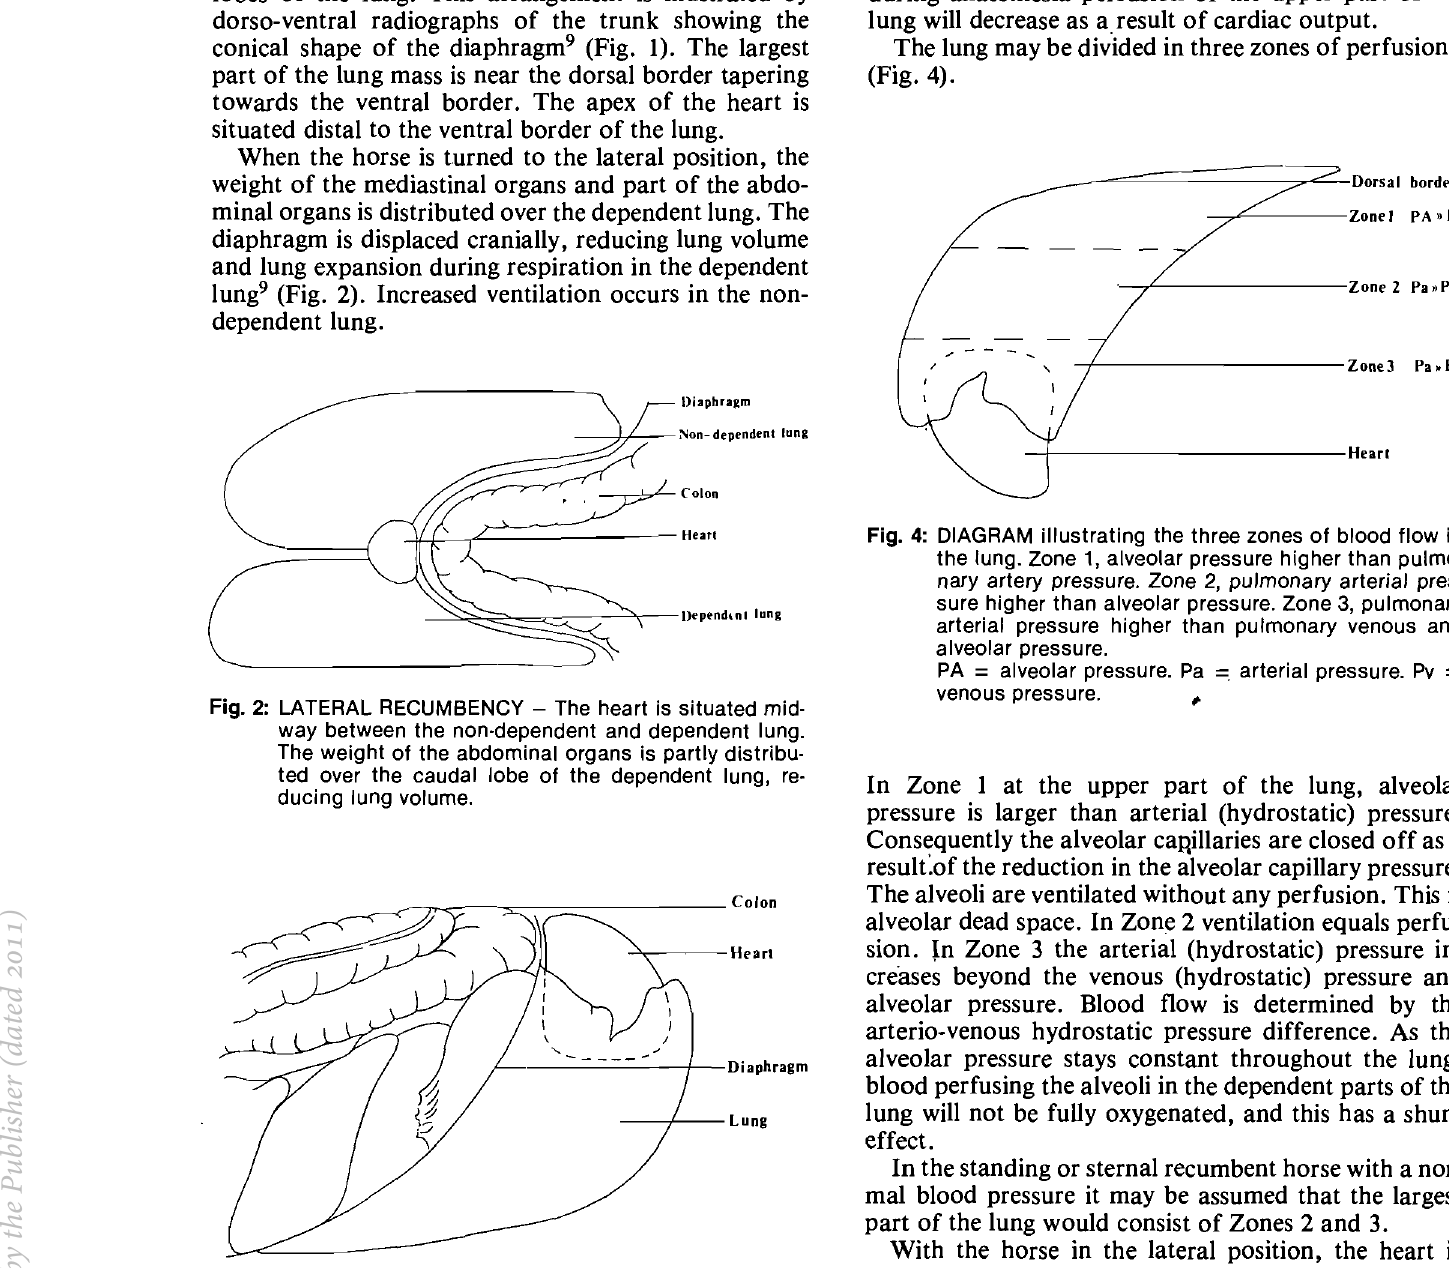
Fig. 3: DORSAL RECUMBENCY - The heart lies dorsal to the lungs and the abdominal organs dorsal to the dia phragm and caudal lobes_ The weight of the abdominal organs is partly distributed over both caudal lobes, re- ducing lung volume.